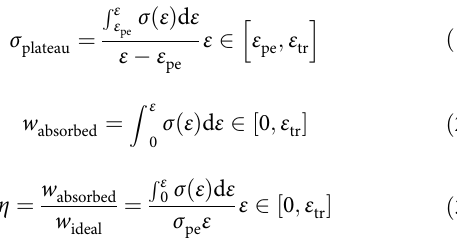
Fig. 1 Design and fabrication of shear-mode AFM probes based on cellular CMA tips. a The geometrical design of the CMA body. The mechanical behavior can be tuned by adjusting the unit side length (indicated by the scalar variable “ a ” in the fi gure and context). b Schematic of the CMA structure- based AFM tip. c Photographic image of the assembled AFM probe and the microscopic view of its components, which includes a commercial tip mount with a vertical tuning fork, a single-mode fi ber, and a cellular CMA structure direct laser written on top of the fi ber facet, as shown in the insets. d , e Scanning electron microscopy (SEM) images of the CMA structures ( a = 5 μ m, 15 stacking layers of cellular units). f SEM image of the tip apex with ~47 nm radius. Scale bars are 2 mm, 10 μ m, 2 μ m, 500 nm for ( c – f ), Fig. 2a, which are given as a function of variable strain ε by: